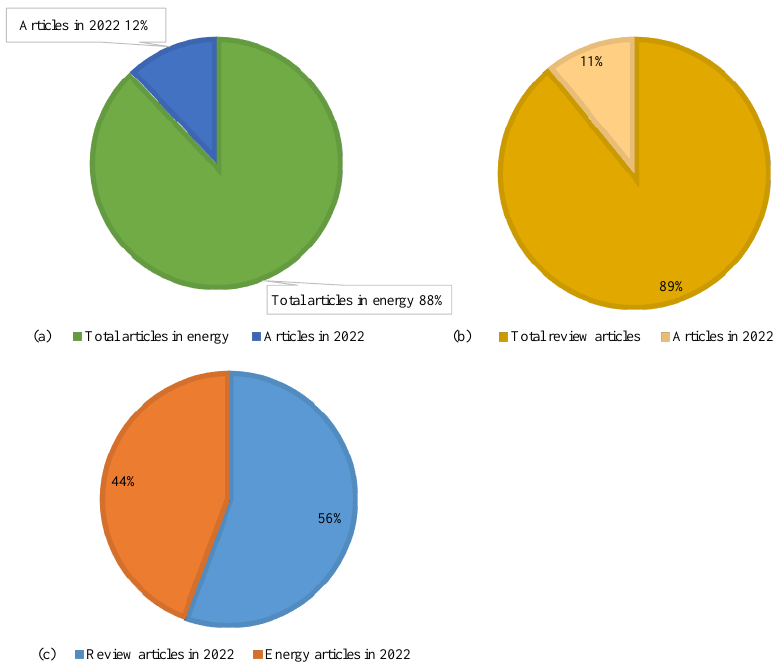
Figure 2. Comparison of the number of papers between 2022 and 2010 ∼ >2022 (sciencedirect.com on 19 December 2022 at 2.30 pm KST); ( a ) energy articles, ( b ) review articles, and ( c ) review versus energy articles in